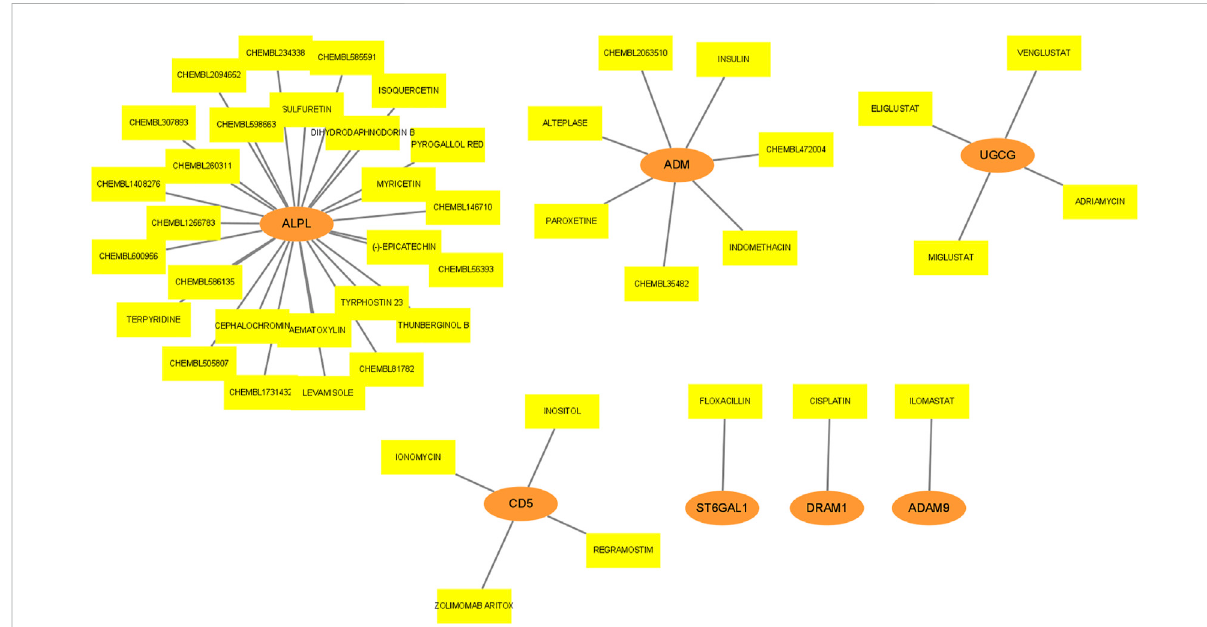
FIGURE 8 DrugpredictionformRNAinlncRNA-miRNA-mRNAnetwork.TheorangeellipsesrepresentmRNAs,andtheyellowrectanglesrepresentdrugs targeted by mRNAs.